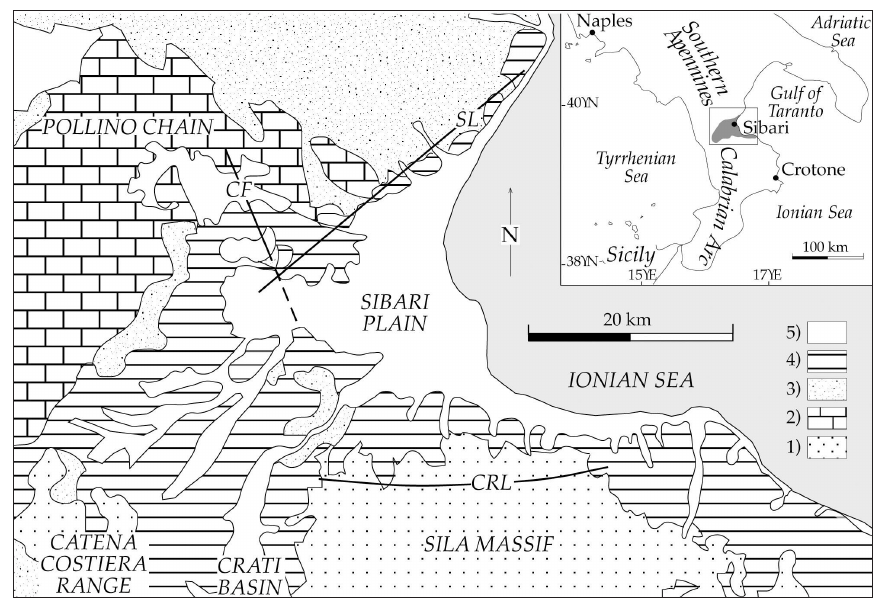
Fig. 1. Geological sketch of the study area. The grey zone in the inset shows the area occupied by the marine terraces. Legend: 1 – Calabride Complex (Paleozoic); 2 – Campania-Lucania carbonate platform (Mesozoic); 3 – liguride complex (Lower Cretaceous-Jurassic) and turbidites cover (Paleogene); 4 – marine terrigenous and fan deltas deposits (Middle Pleistocene-Upper Pliocene); 5 – continental and marine deposits (Holocene-Upper Pleis- tocene). Fault abbreviations: CF – Castrovillari Fault; SL – Sangineto Line; CRL – Corigliano-Rossano